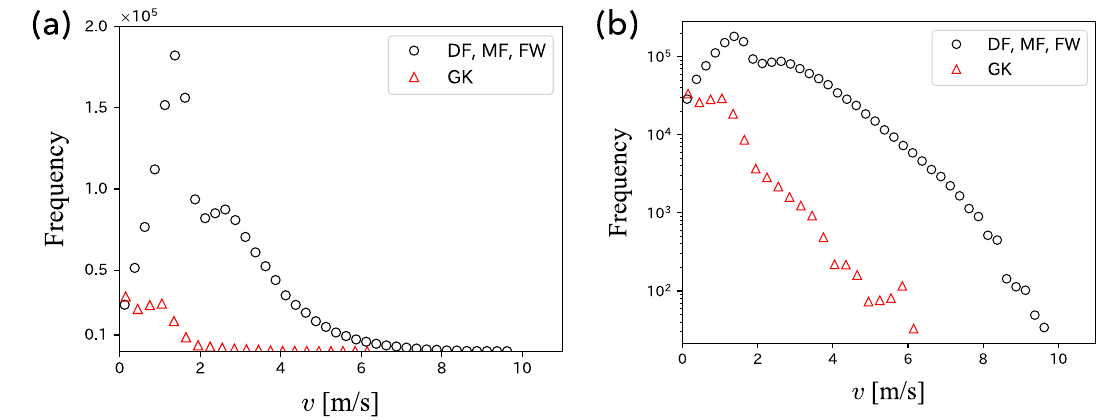
Figure 1. Speed distributions of soccer players. ( a ) Linear plot and ( b ) semi-logarithmic